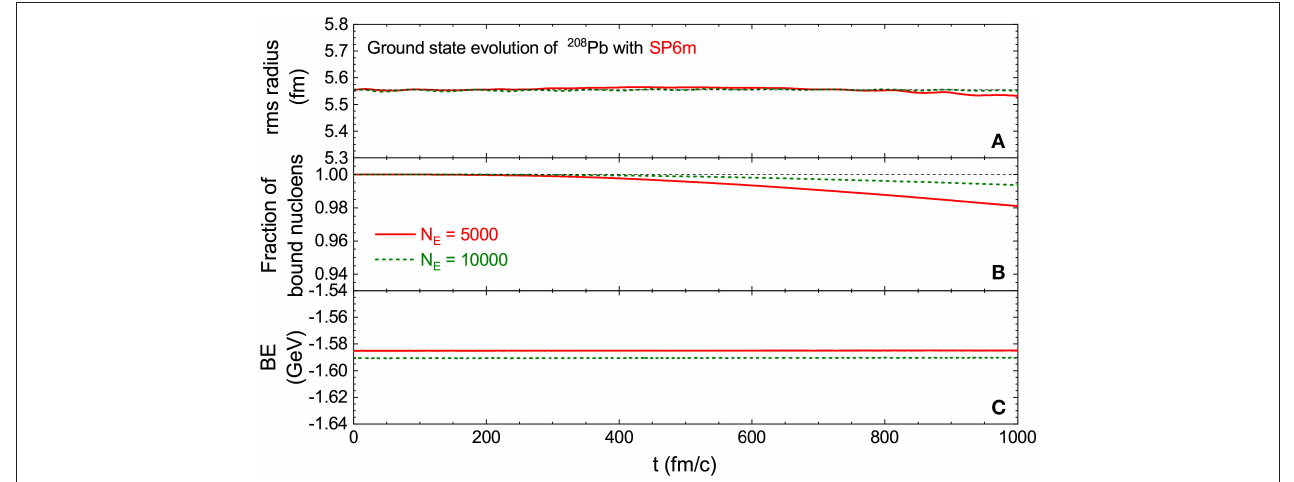
FIGURE 3 | Time evolution of (A) rms radius, (B) fraction of bound nucleons, and (C) binding energy of the 208 Pb ground state from the LHV calculation (i.e., the LBUU calculation without NN scatterings) with the N3LO Skyrme pseudopotential SP6m up to 1,000 fm / c . Calculations are performed with a time step of 1 t 0.4 fm / c and with N E 5,000 and 10,000. Reproduced from reference [ 61] with permission from the American Physical = =